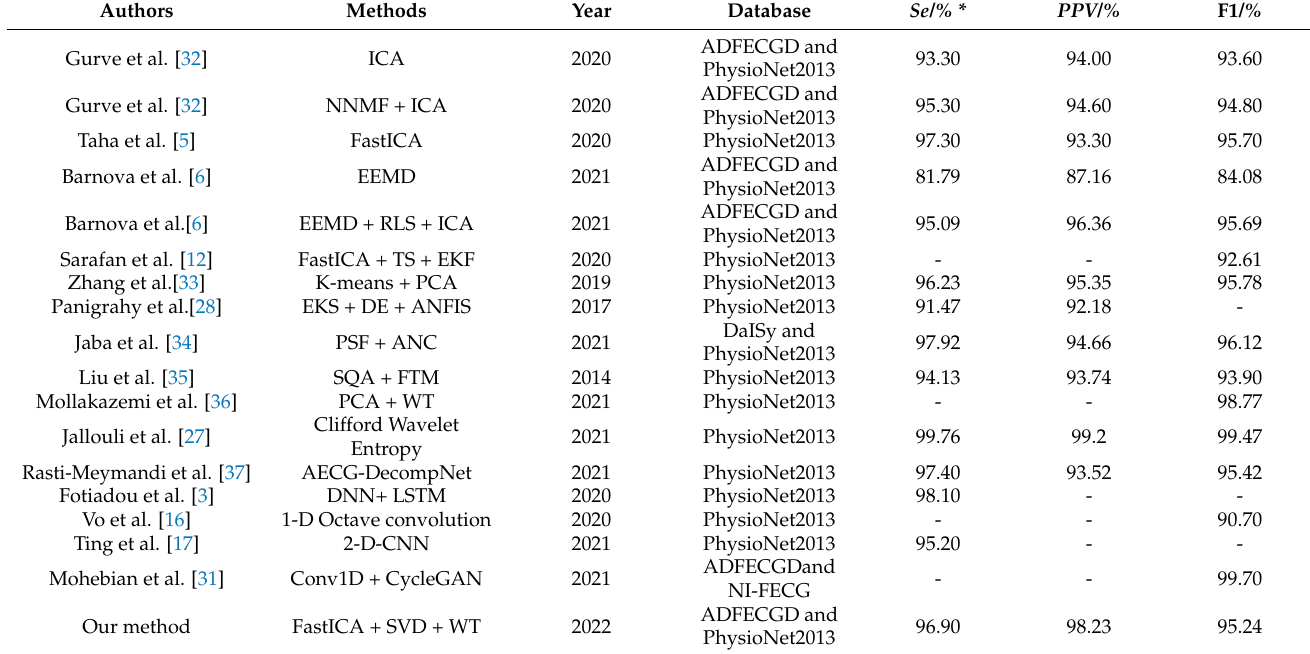
Table 5. Comparison with published state-of-the-art methods for FECG signals